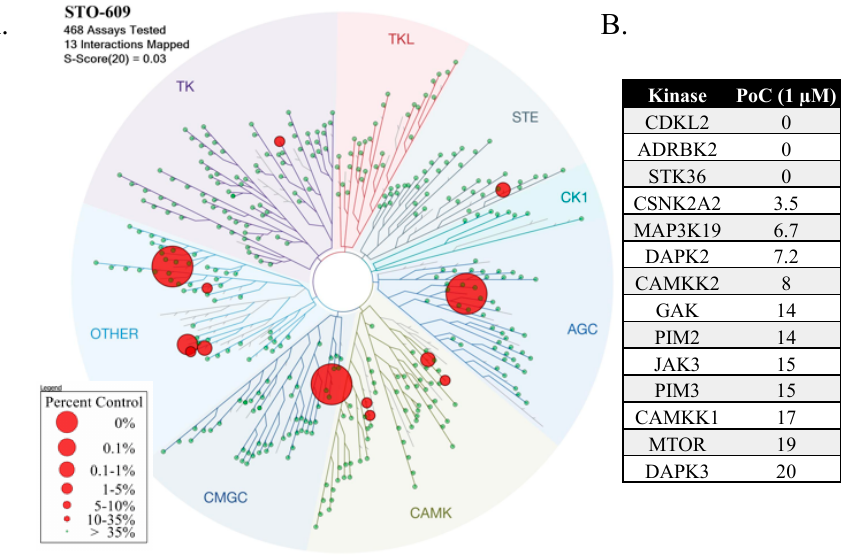
Figure 3. Selectivity and o ff -targets of STO-609 evaluated at 1 µ M. ( A ) Kinome treespot showing location of kinases that STO-609 binds to. ( B ) List of kinases and their percent of control (PoC) remaining when treated with 1 µ M of